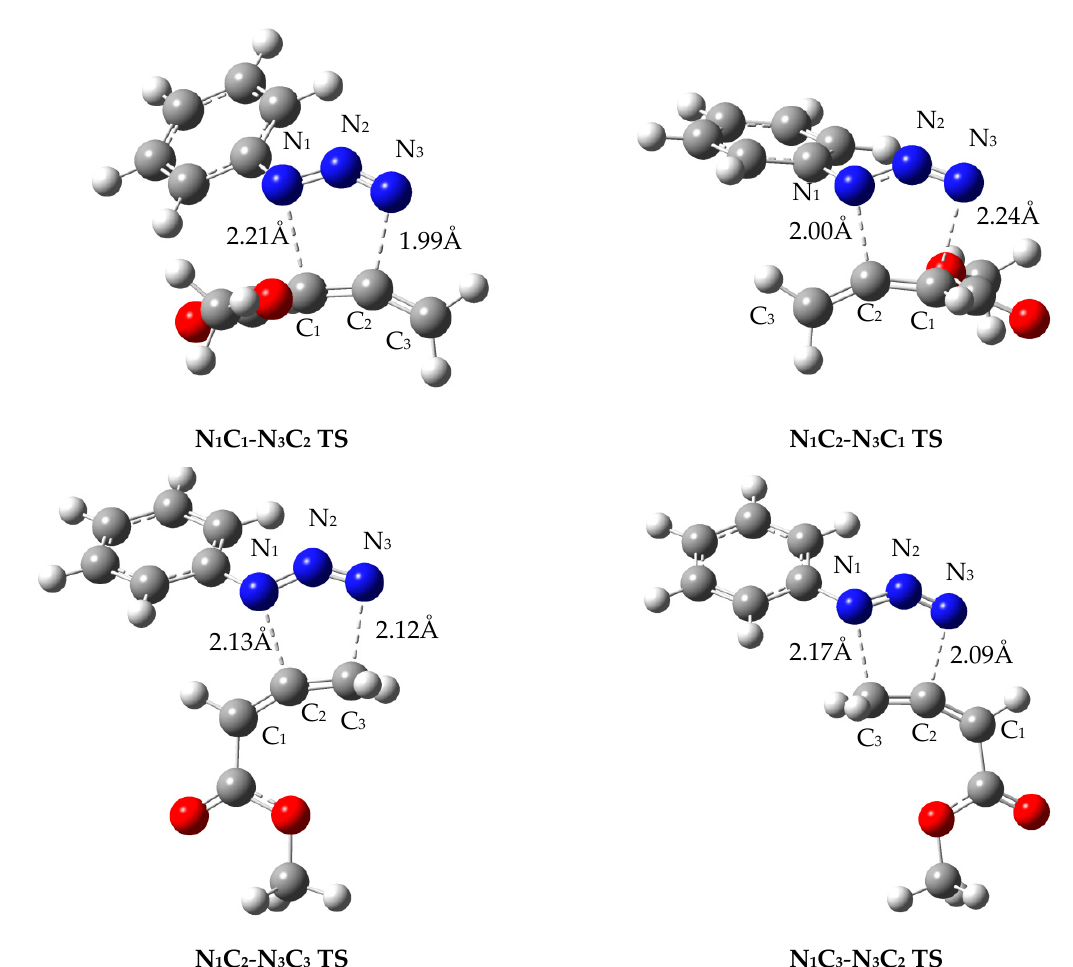
Figure 2. Structure of the transition states leading to the primary cycloadducts of the 1a + 3a cycloaddition calculated at the M08-HX/pcseg-2 level. Colour code: carbon, grey; nitrogen, blue; oxygen, red; hydrogen, light grey. The key atoms are numbered as in the text.